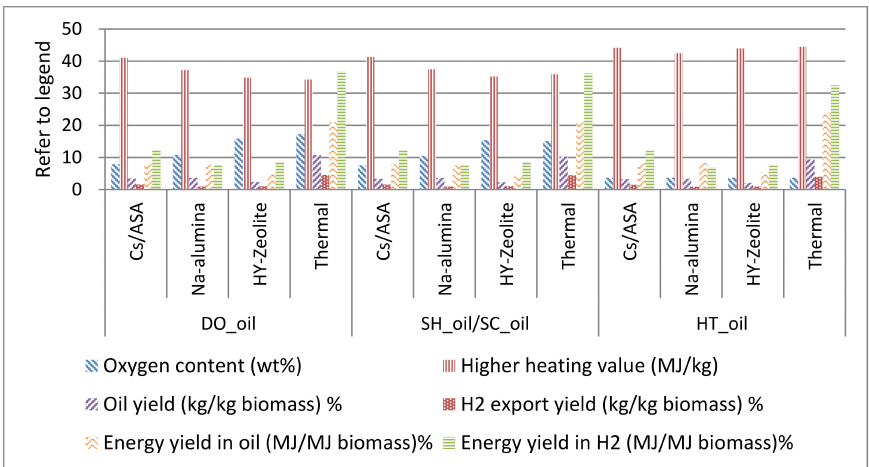
Figure 4. Comparison of product properties and yields for di ff erent scenarios of catalytic and thermal pyrolysis processes. Data values for this graph are provided in the Supplementary Materials, Table